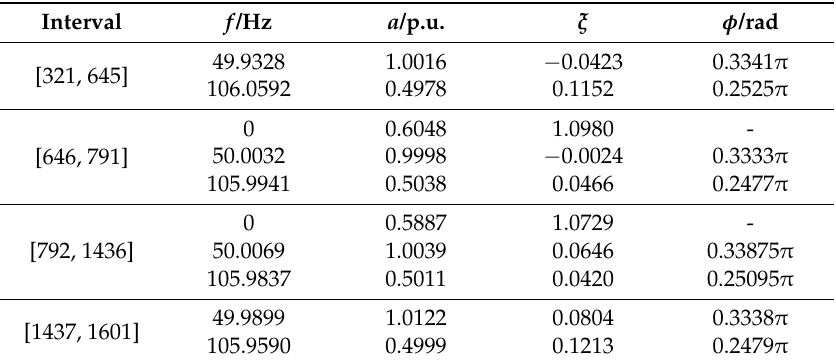
Table 5. Parameter identification of Equation (21).